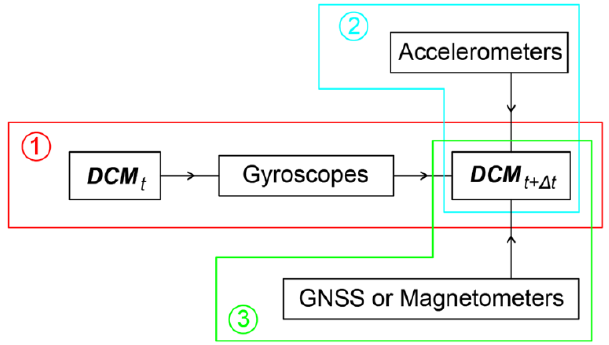
Figure 4. General flowchart for calculating the rotation matrix by combining outputs from all available sensors.